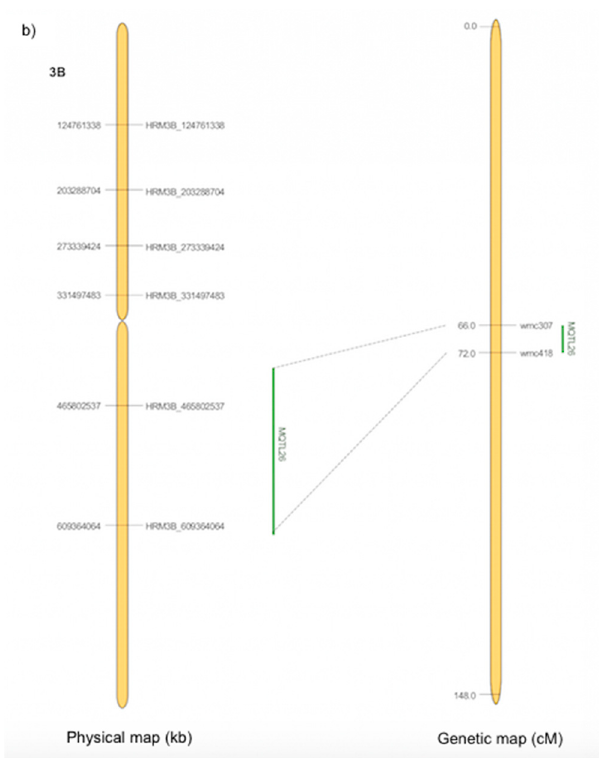
Figure 3. Physical and genetic maps for markers located in chromosome 4A ( a ) and 3B ( b ) including location for meta-quantitative trait loci (MQTLs) [71] associated to heat and drought stresses tolerance. Markers used in variability assessment are shown in blue color. MQTLs are indicated using green lines.